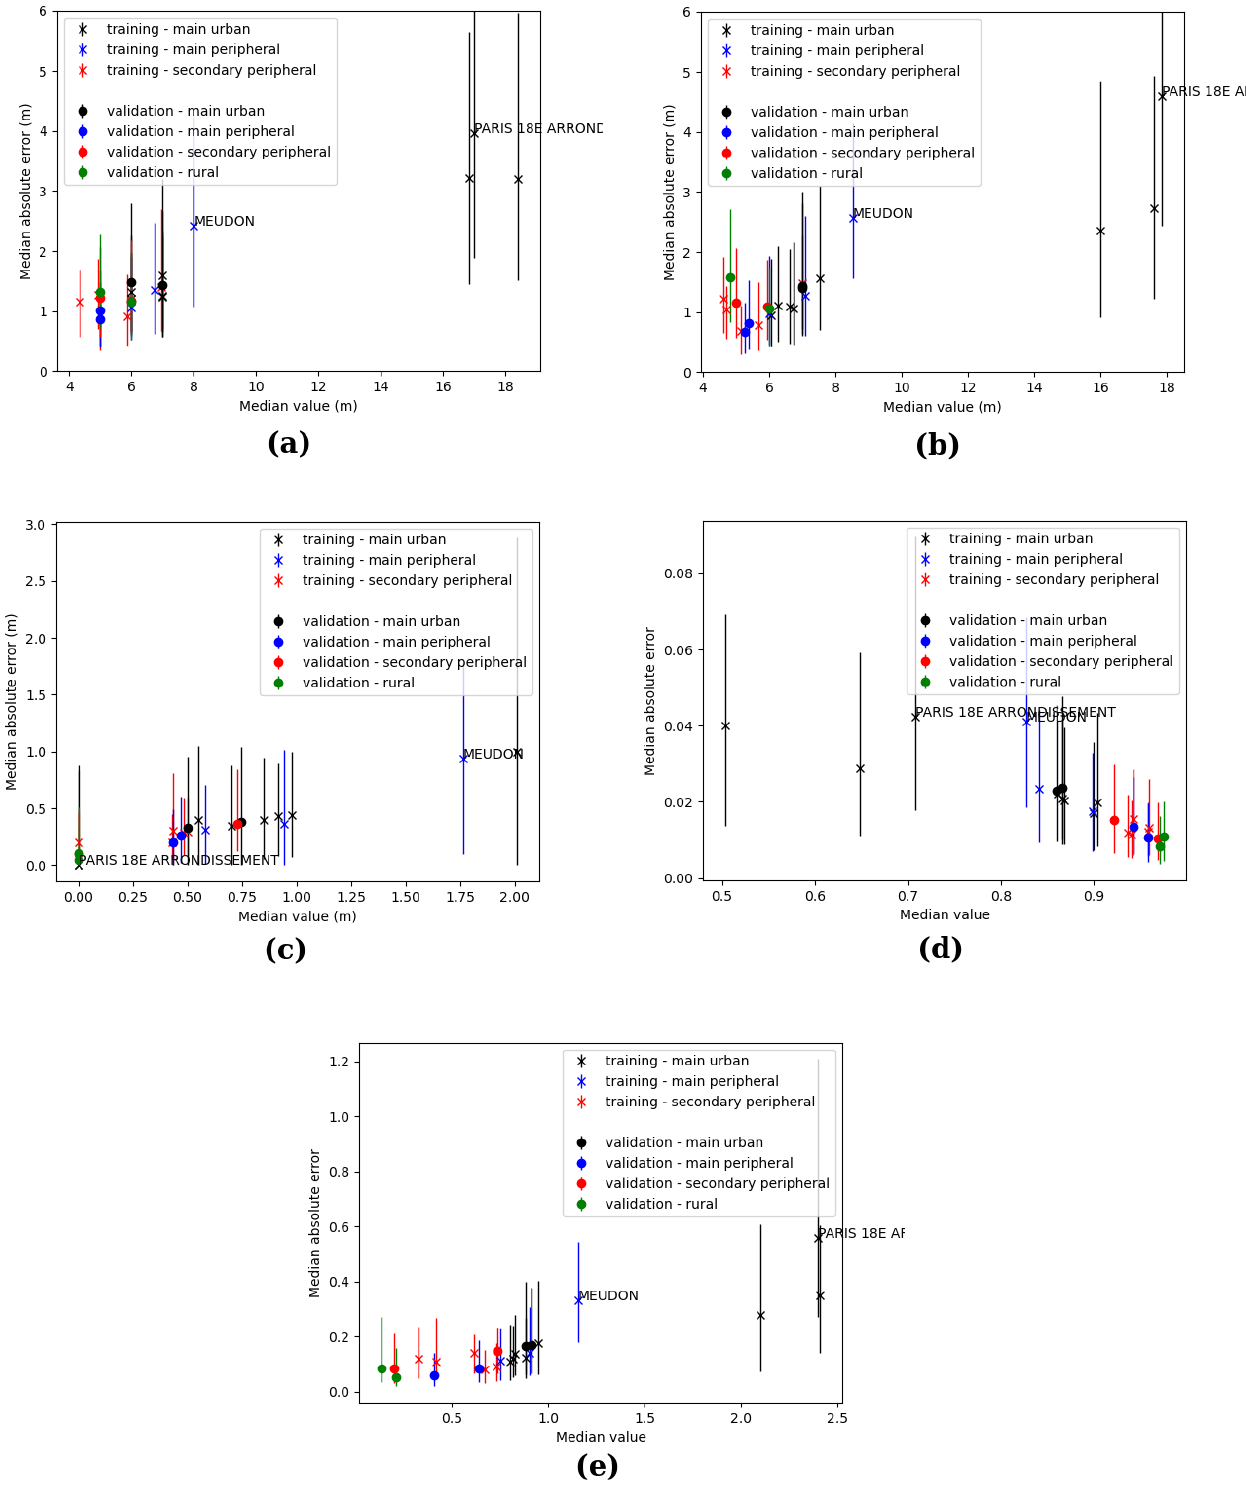
Figure 6. Median absolute error versus median true value for (a) building height, (b) RSU average building height, (c) RSU standard deviation building height, (d) RSU mean ground sky view factor, and (e) RSU effective terrain roughness length. The cross and the dot are the medians, while the whiskers are the first and third